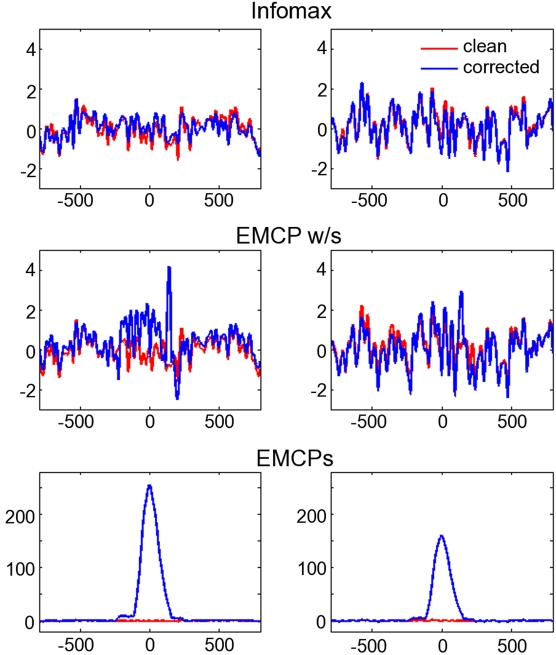
Propagation model with constant blink amplitude.Averages time-locked to the maximum blink excursion (x-axis: time (ms); y-axis: µV). Only two channels are plotted (left and right column respectively). Red lines: clean, uncontaminated data; Blue lines: corrected data. Note the difference in the scaling for the EMCPs-corrected data. Also note that the channels for the propagation model have been chosen randomly, as well as the propagation factors used for simulation of blinks. Hence the real names (like “FCz”) are not informative, since they don't have spatial information anymore.